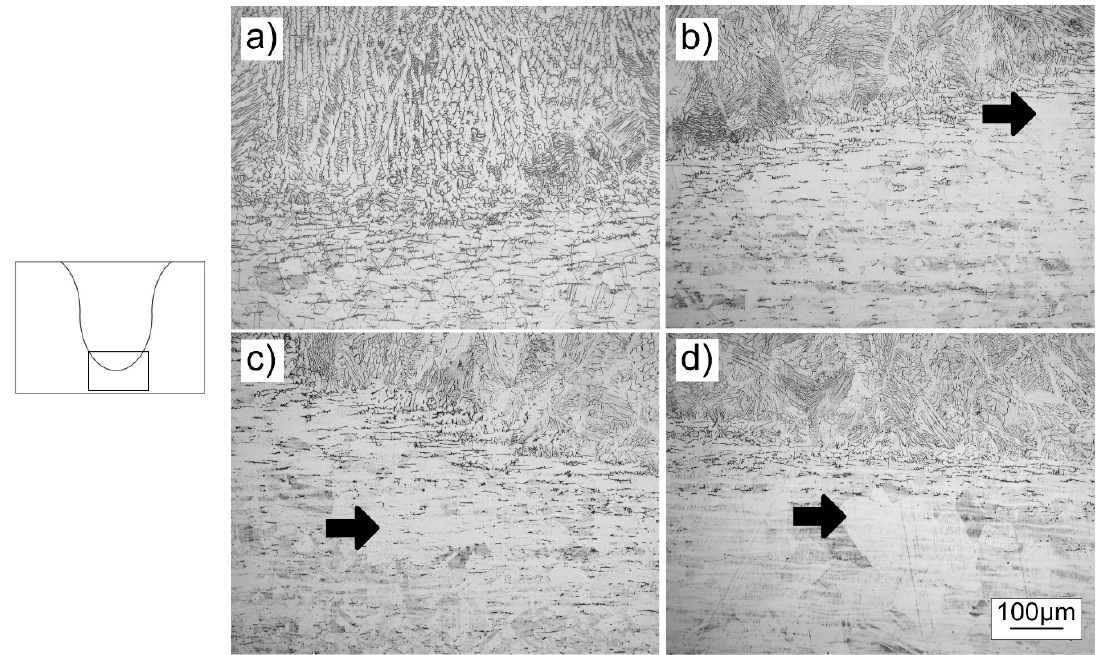
Figure 5. Microstructures under the weld metal near the melt line: ( a ) specimen 0; ( b ) specimen 5Si;